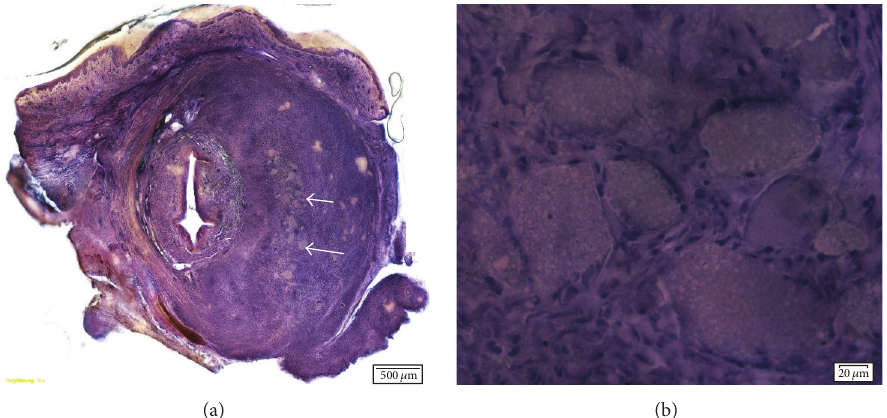
Figure 3: Cross-sections of rat urethra 5 months after injection of Cristobalite particles. (a) Cross-sectional view of the entire urethra (10x magnification). Arrows indicating particle mass. (b) Image showing particles with a slight variability in size and surrounding fibroblastic proliferation (20x magnification).